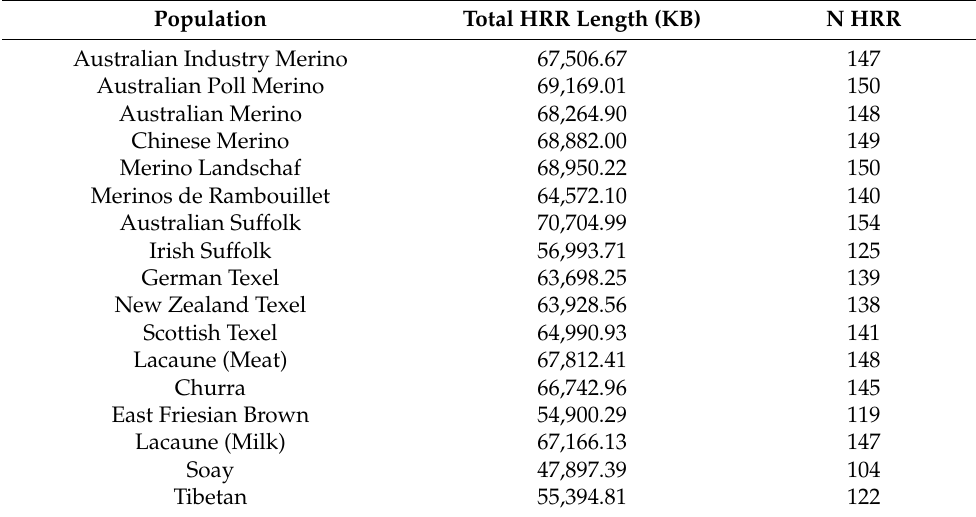
Table 3. Averages of total heterozygosity-rich regions’ (HRRs) length (KB) and number of HRRs per animal in 17 worldwide sheep